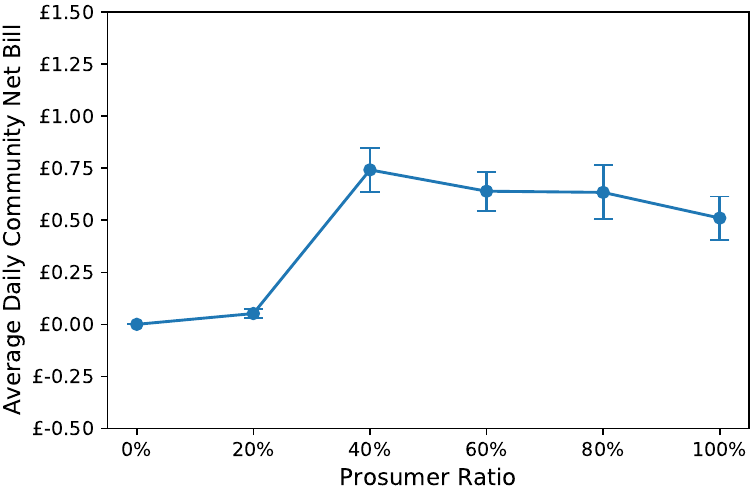
for the simulations with perfect predictions without storage. A deficit Figure 5. Daily average B C K exists a result of the imperfect overlap between supply and demand. The deficit is noticeable with a prosumer ratio of 40% and higher as more energy is traded within the market. The error bars represent 95% confidence